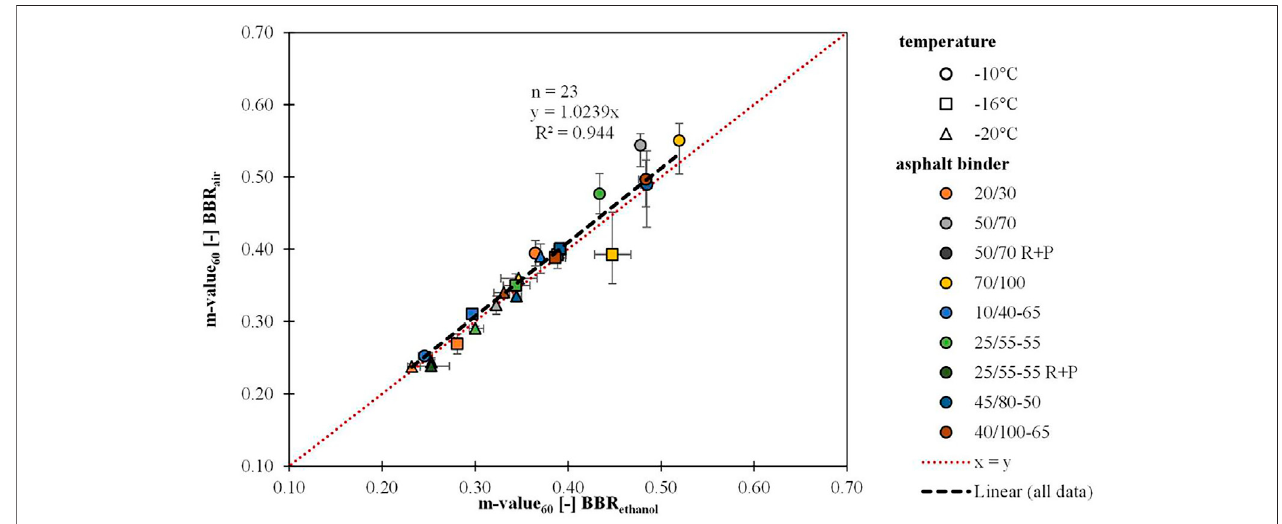
FIGURE 9 | Correlating fl exural creep stiffnesses (S 60 ) obtained from BBR tests and DSR tests.